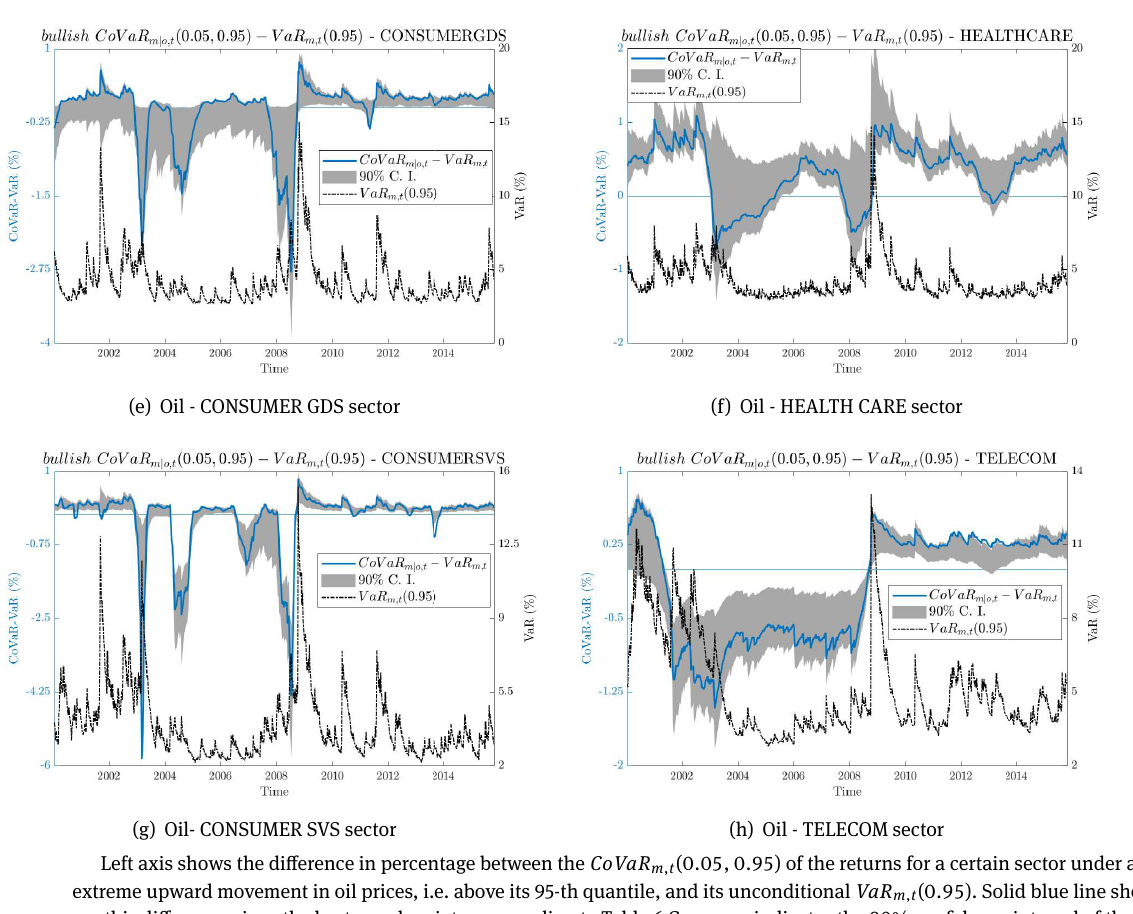
Figure 17b: CoVaR m | o , t (0.05, 0.95) for a certain sector given a bullish scenario for oil